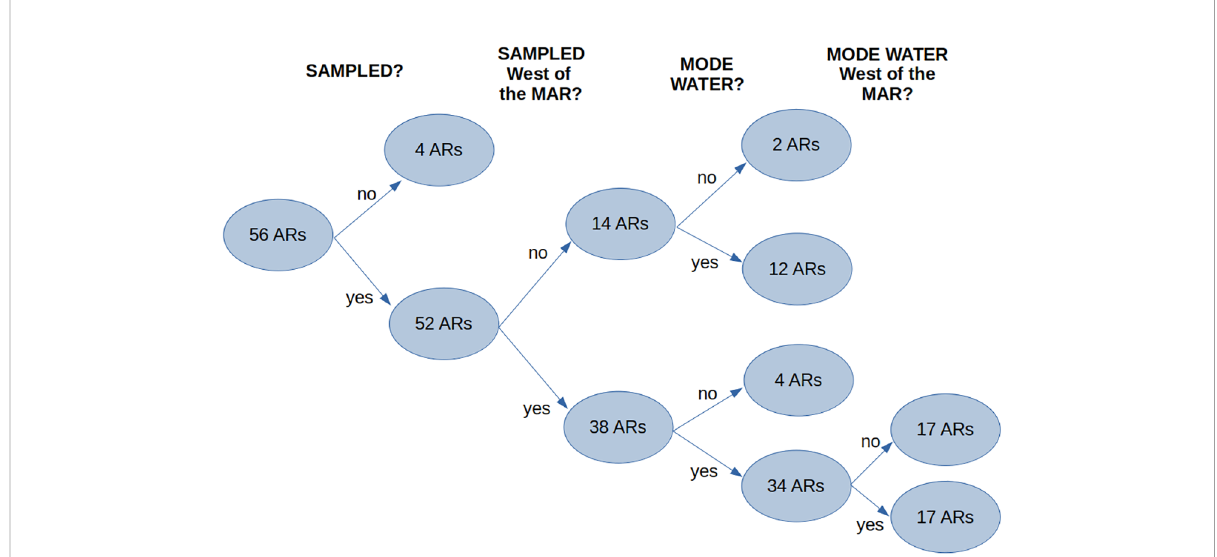
FIGURE 3 The Agulhas rings (ARs) classi fi cation according to sampling and presence of mode waters passed through a dichotomous tree. The 13°W meridian was used as a watershed for the South Atlantic, representing the Mid-Atlantic Ridge